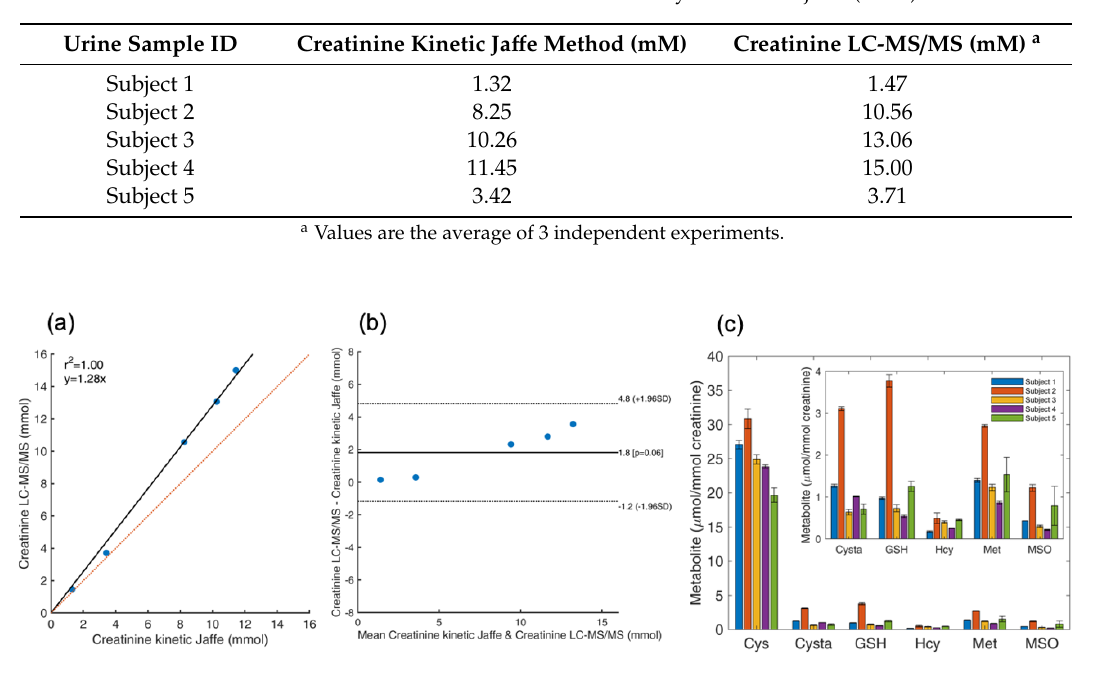
Figure 5. Analysis of thiol and thioether metabolites and creatinine in human urine. Panel ( a ). Correlation of creatinine concentration determined by the kinetic Ja ff e method versus our LC-MS / MS platform. The orange line represents the expected fit for perfect correlation of values (slope = 1). Panel ( b ). Brand-Altman plot examining the performance of our LC-MS / MS platform in the determination of urinary creatinine with respect to results on the same samples obtained with the standardized kinetic Ja ff e method (Central diagnostic laboratory, Medical Center, University of Freiburg). Di ff erences in discrete concentration values are within 2 standard deviations ( ± 1.96 SD). Panel ( c ). Profile of thiol and thioether metabolites in human urine normalized by creatinine. Values are expressed as the mean ± standard